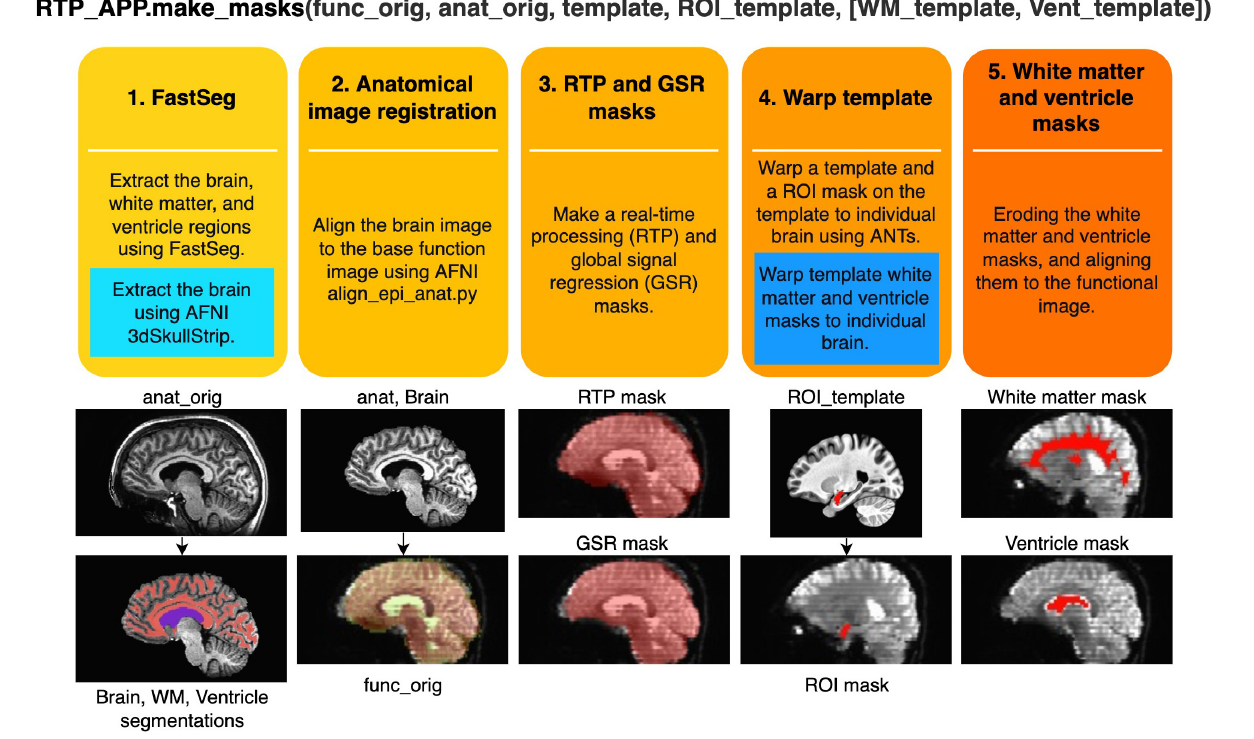
FIGURE 3 | Procedures of creating image masks in the “ make_masks ” method of RTP_APP. Two blue boxes show the procedures used in the alternative stream without using FastSeg. In the alternative stream, the first process is replaced by a blue box, and the fourth process is performed by adding the procedure in the blue box. The images below demonstrate what image processing is done at each